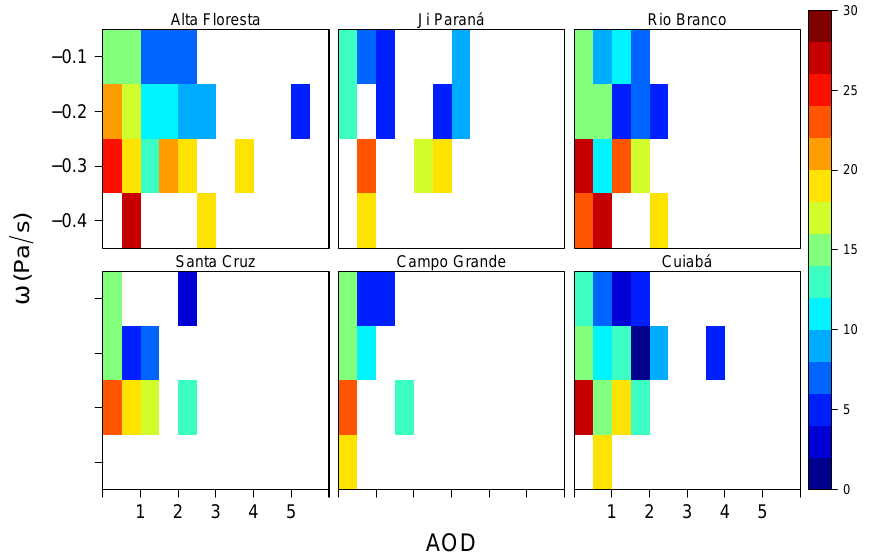
Fig. 9. Two-dimensional histogram of the average rainfall rate for each AERONET station for all selected cases (see Sect. 2.4) during the months of September, October, November and December of 1999–2012. Colors indicate average rainfall rate for each bin of ω and